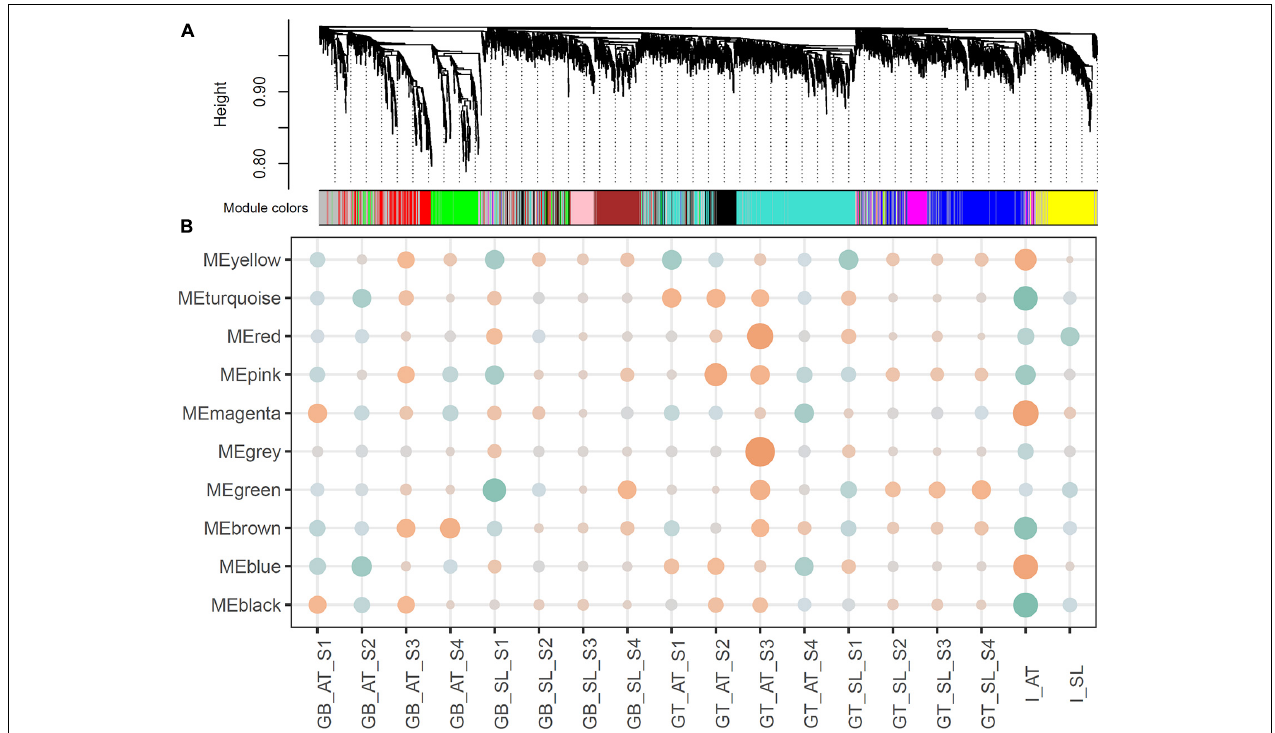
FIGURE 2 | (A) Hierarchical clustering and co-expression modules. The hierarchical cluster tree shows gene co-expression modules identified by WGCNA. The branches constitute 10 modules labeled in different colors. (B) Relationships between modules and traits. Correlation coefficients are shown by color (orange for positive and green for negative). The size represents the degree of significance, calculated as − log2 ( p